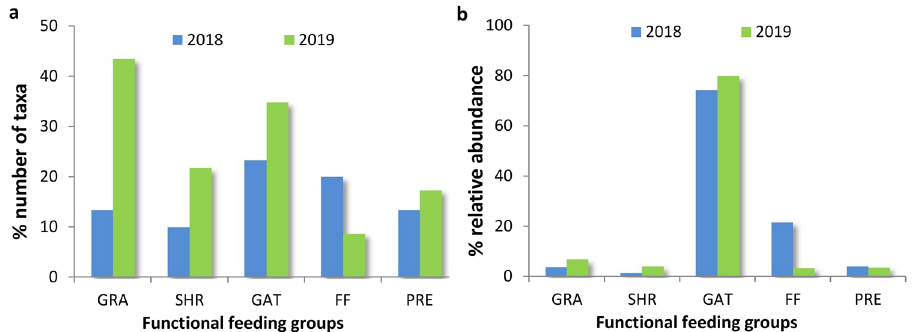
Figure 2. Percentage number of taxa ( a ) and relative abundance of organisms ( b ) in the assigned FFGs. GRA – grazers/scrapers, SHR—shredders, GAT—gatherers, FF—filter feeders, and